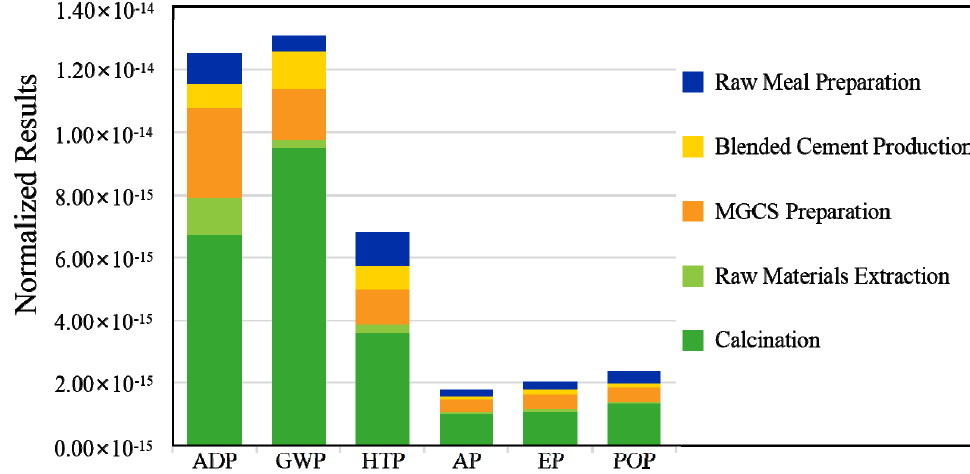
Figure 3. Environmental impacts of each stage to the environmental impact (normalized results). Table 3. Contribution of each stage on selected impact categories (Normalization).